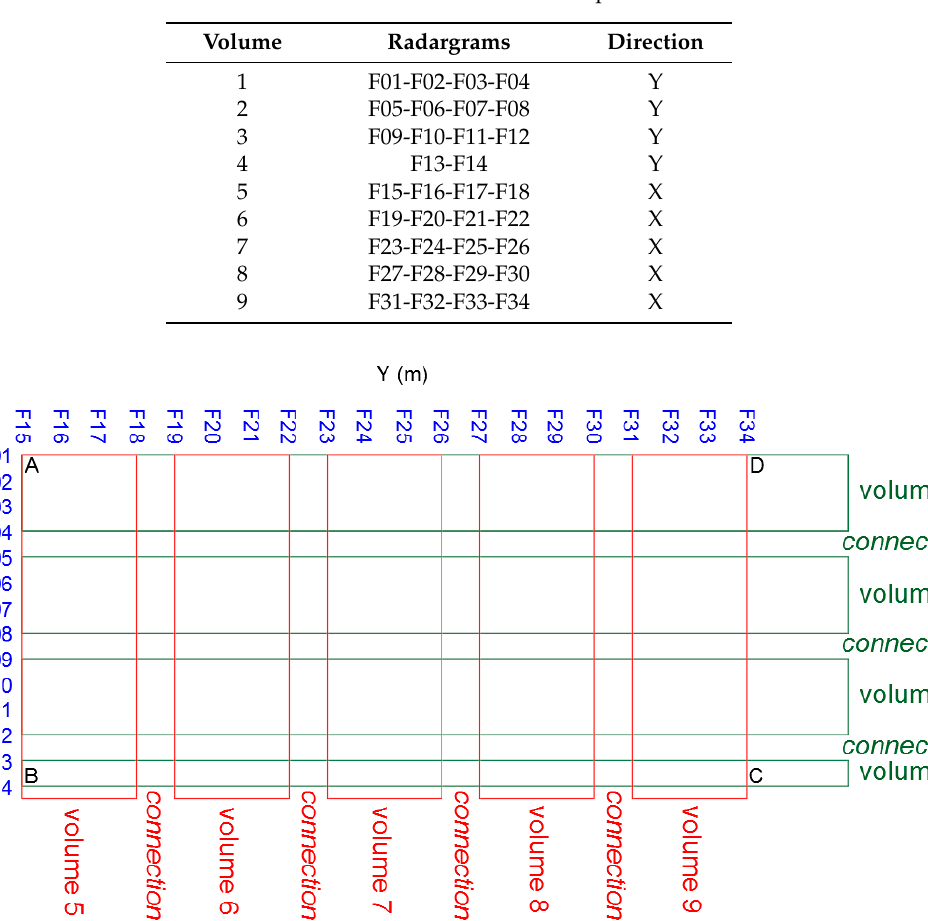
Table 1. The volumes used for the interpretation.